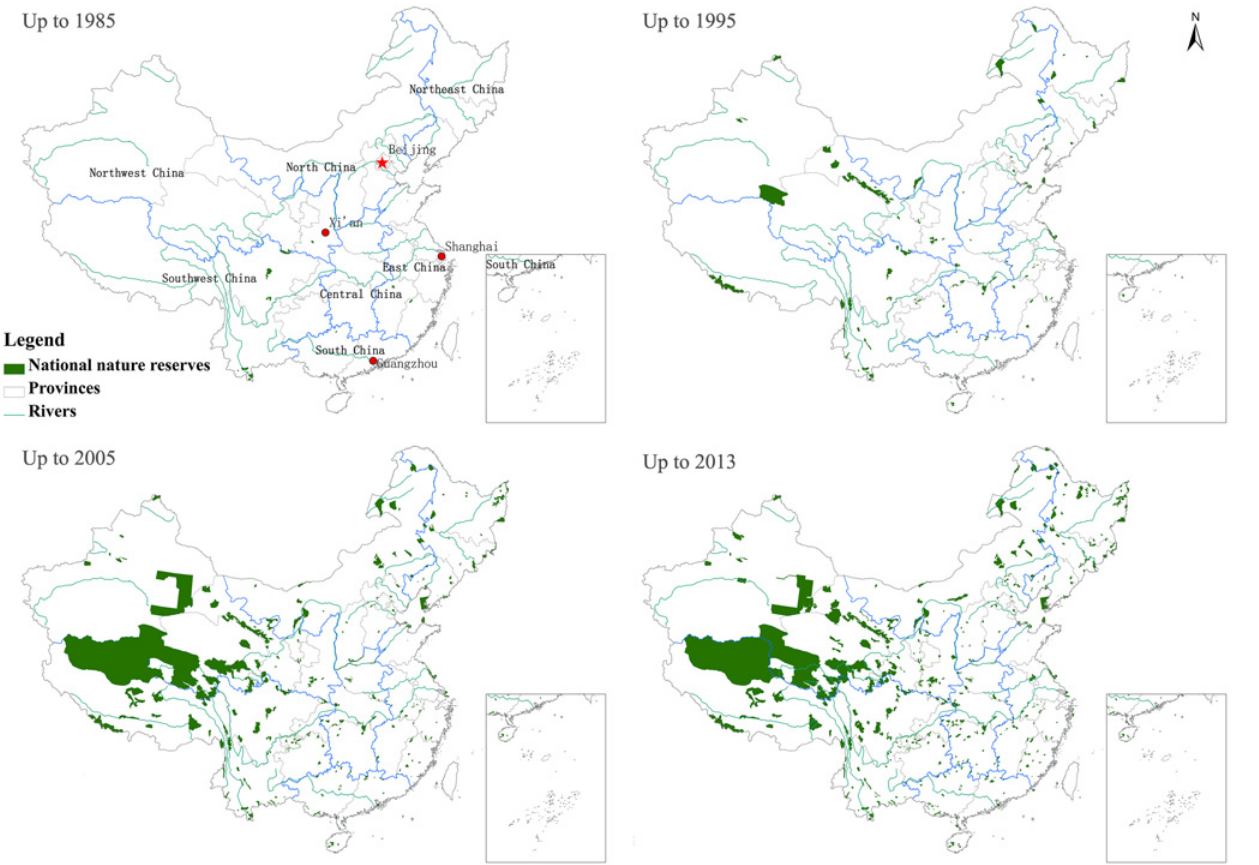
Fig 4. Changes in the spatial distribution of